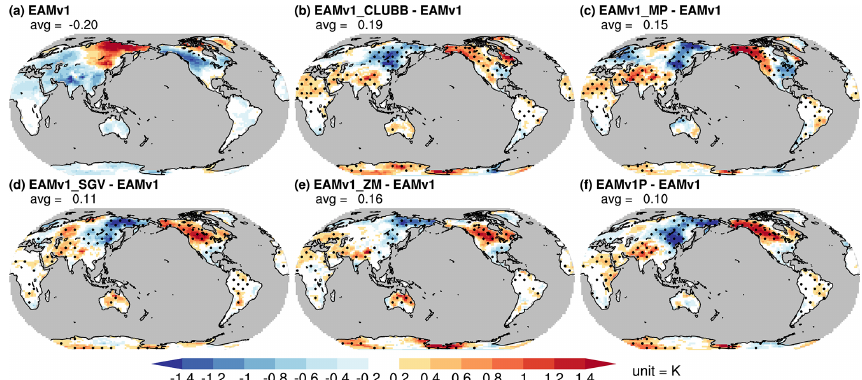
Figure 15. Aerosol-induced changes in land surface